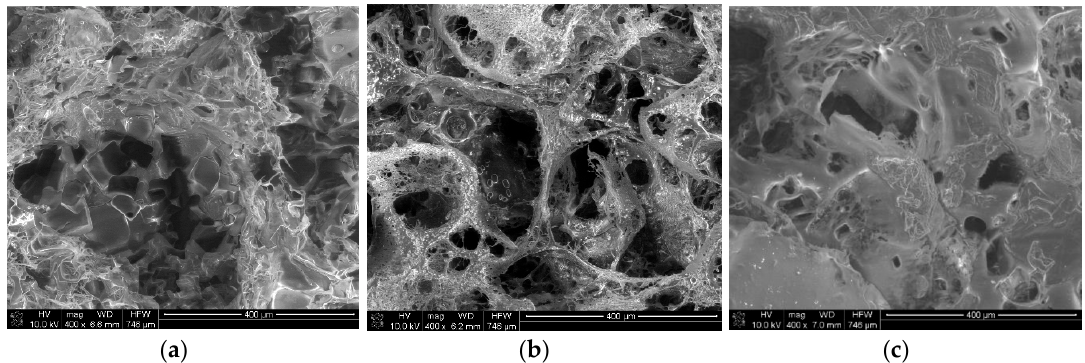
Figure 2. The SEM picture of the porous materials formed via the salt-leaching method from 3% ( a ), 4% ( b ), and 5% ( c ) solution of butyric-acetic chitin co-polyesters 90/10 in ethanol. The mass ratio of inorganic salt and the solution of BAC 90/10 was 6/10.